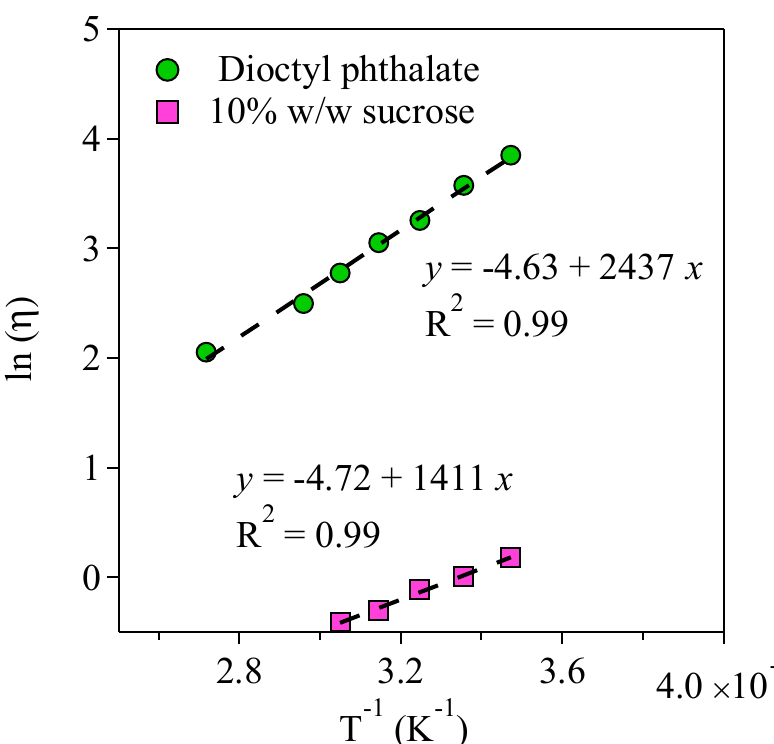
Figure 6. Natural logarithm of the viscosities of the 10% w/w sucrose and dioctyl phthalate as a function of inverse temperature.